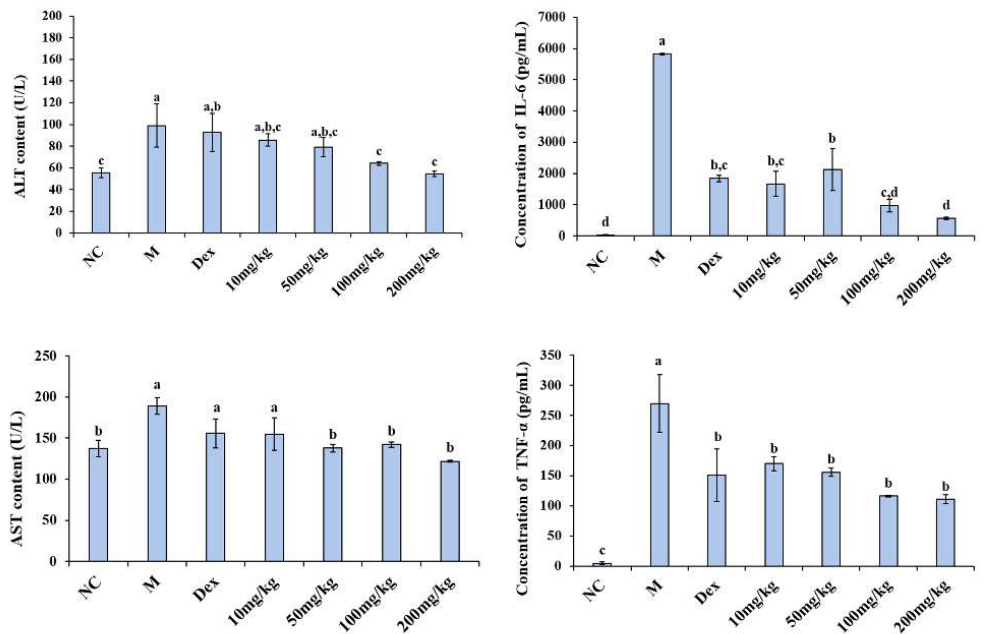
Figure 8. Changes in pro-inflammatory markers and transaminases with 12% COS treatment. M represents the model group; Dex represents the positive control group. The data are presented as means ± SD of three replicates. From “a” to “e”, the mean values decrease in turn. There is no significant difference between groups with the same letter. Different letters indicate individual groups for multiple comparisons with significant differences (one-way ANOVA, Duncan, p < 0.05).